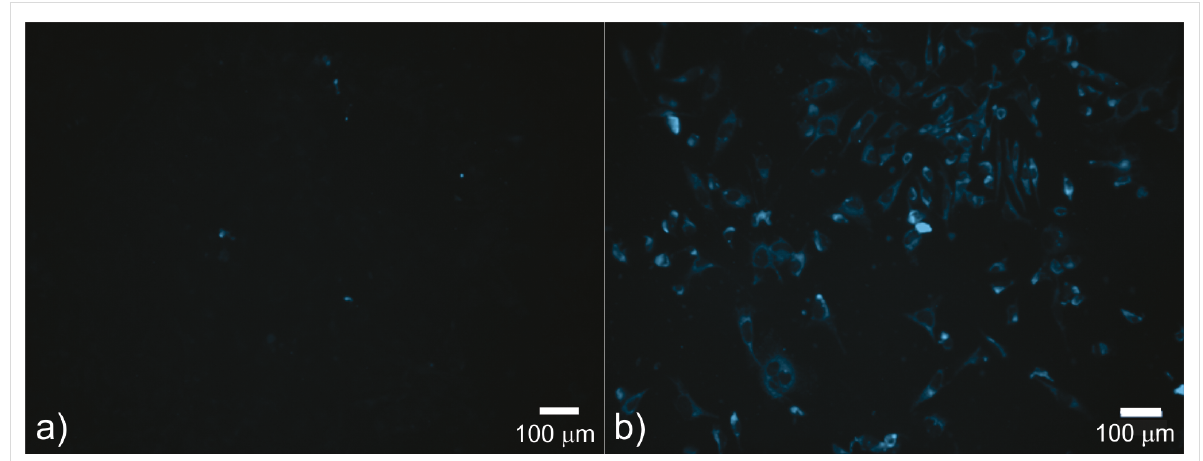
Figure 6: Fluorescence images of (a) HeLa cells treated with vehicle control and (b) HeLa cells treated with CQDs (200 µg/mL) for 48 h. Scale bar is 100